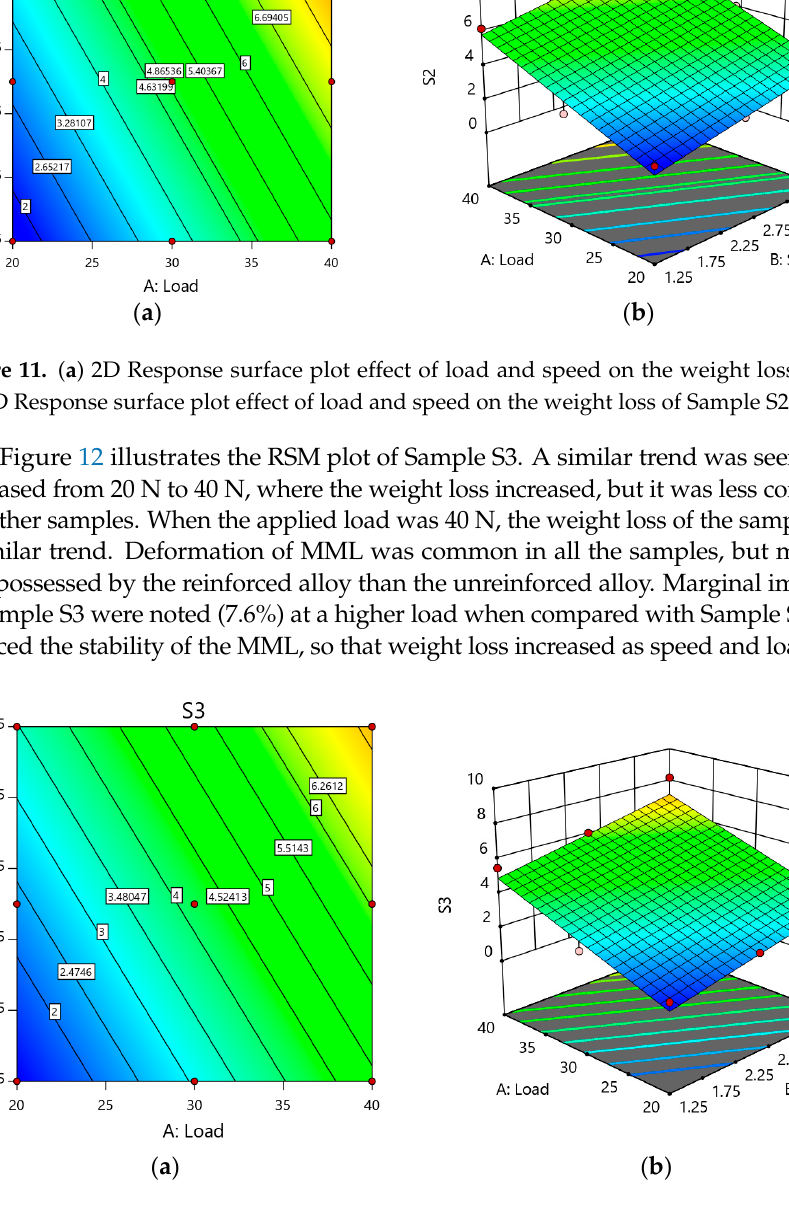
Figure 12. ( a ) 2D Response surface plot effect of load and speed on the weight loss of Sample S. ( b ) 3D Response surface plot effect of load and speed on the weight loss of Sample